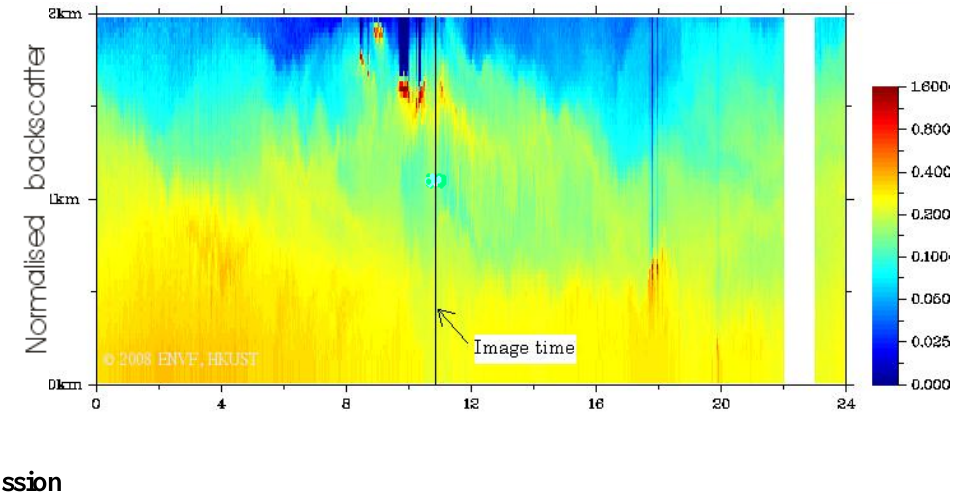
Figure 8 . Lidar backscattering profile over 24 hours on 27-Sep-2006 (image acquired from the Institute for the Environment, the Hong Kong University of Science and